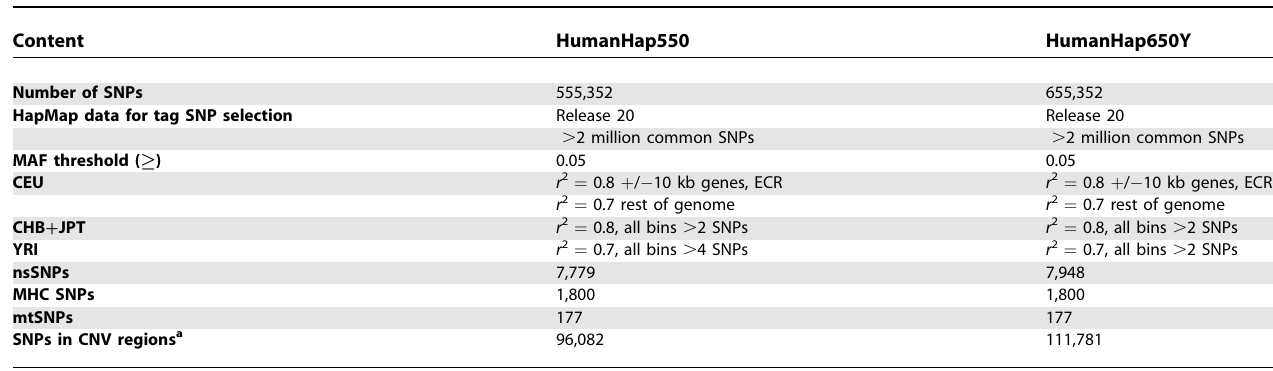
Table 1. HumanHap550 and HumanHap650Y Coverage